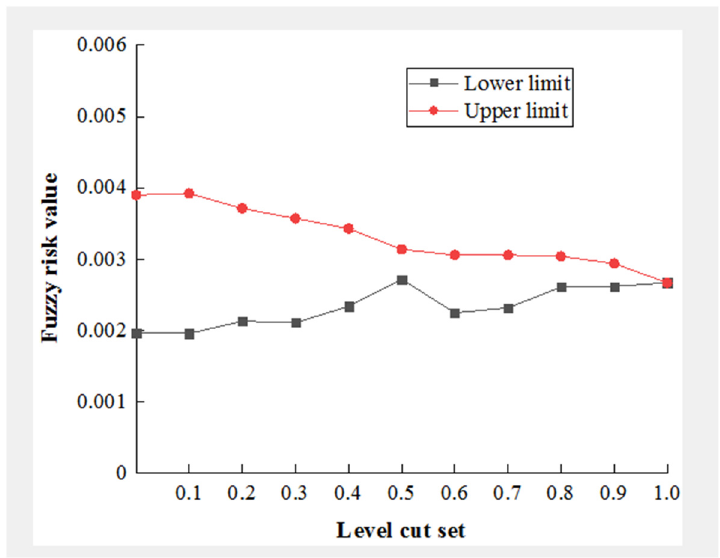
Figure 2. Relationship between level cut set and fuzzy risk